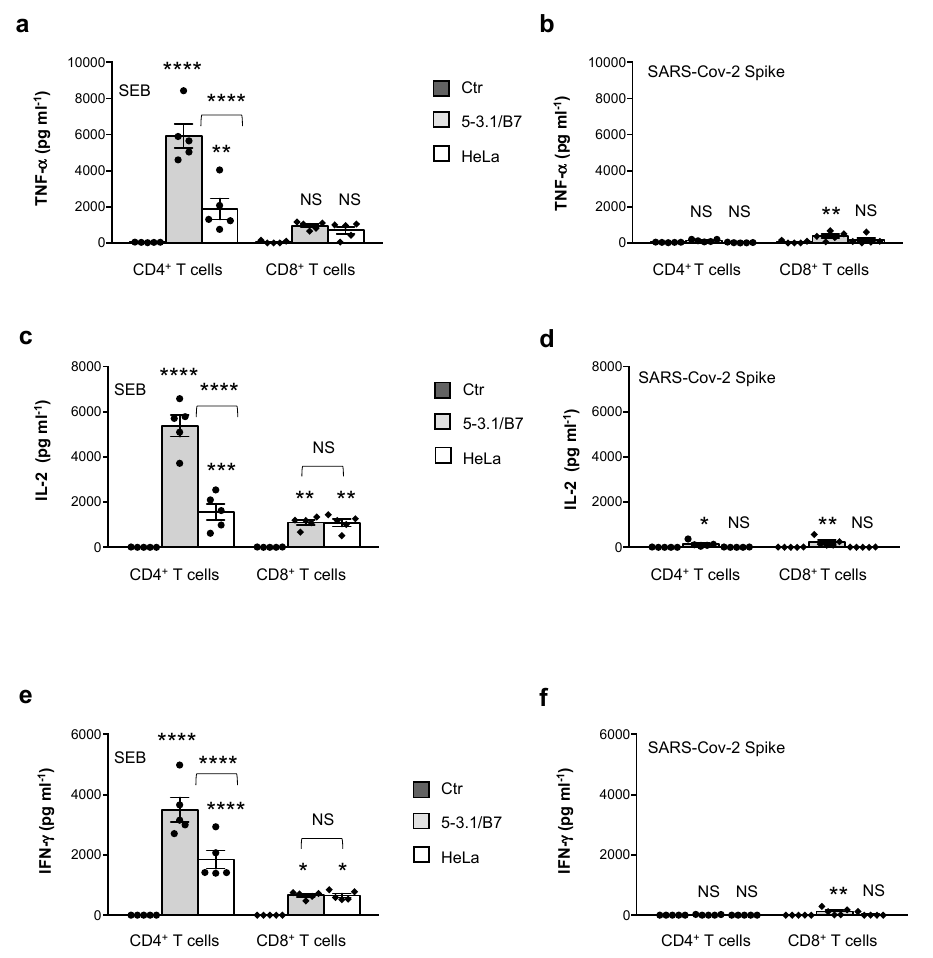
Figure 4. SARS-CoV-2 spike does not stimulate inflammatory cytokine production in CD4 + or CD8 + T cells stimulated with HeLa cells expressing HLA-A*0201. ( a – f ) Peripheral blood CD4 + T and CD8 + T cells from HD (n = 5) were cultured for 24 h with medium alone (Ctr) or SEB ( a , c , e ) or SARS-CoV-2 spike ( b , d , f ) in the presence of 5-3.1/B7 cells or HeLa cells expressing HLA-A*0201. TNF- α ( a , b ), IL-2 ( c , d ) and IFN- γ ( e , f ) secretion in culture supernatant was measured by ELISA. Data show the mean ± SEM. Statistical significance was calculated by comparing each condition with unstimulated cells cultured with medium alone (Ctr) or between conditions indicated by the arcs by one-way